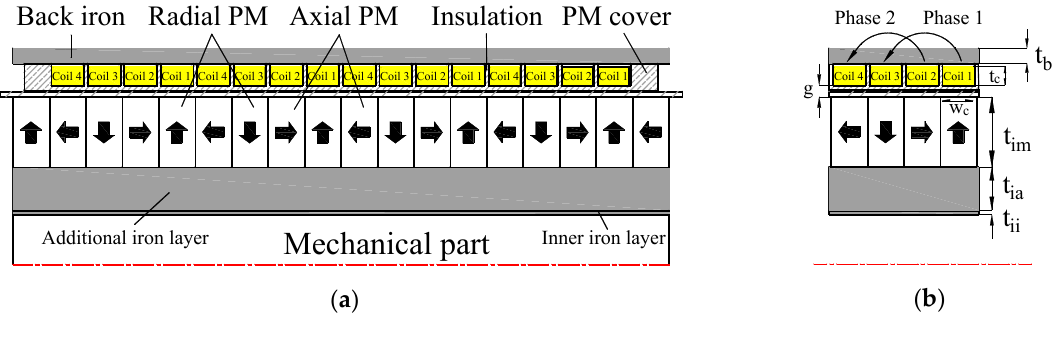
Figure 1. ( a , b ) Half cross-section of the single PM layer coreless model.